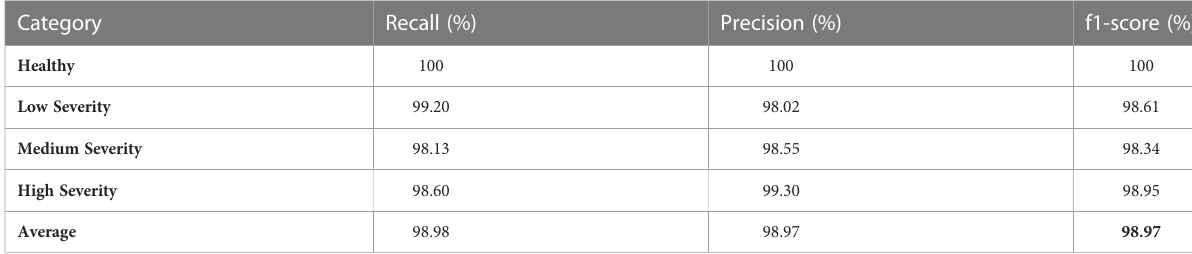
TABLE 5 Class-wise performance of the proposed model.